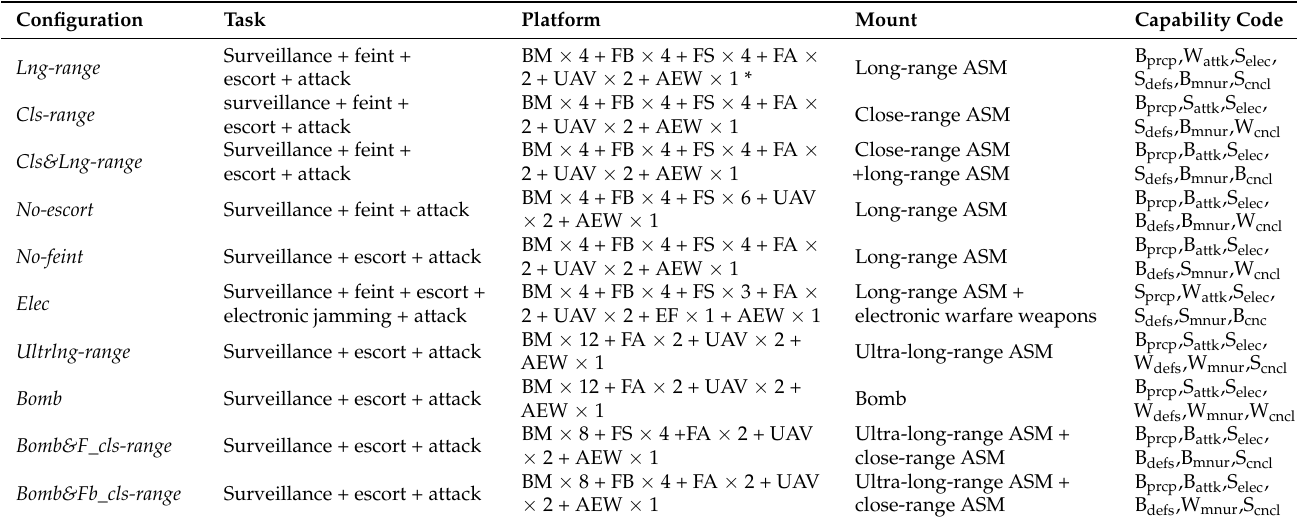
Table A1. MPAMS configuration